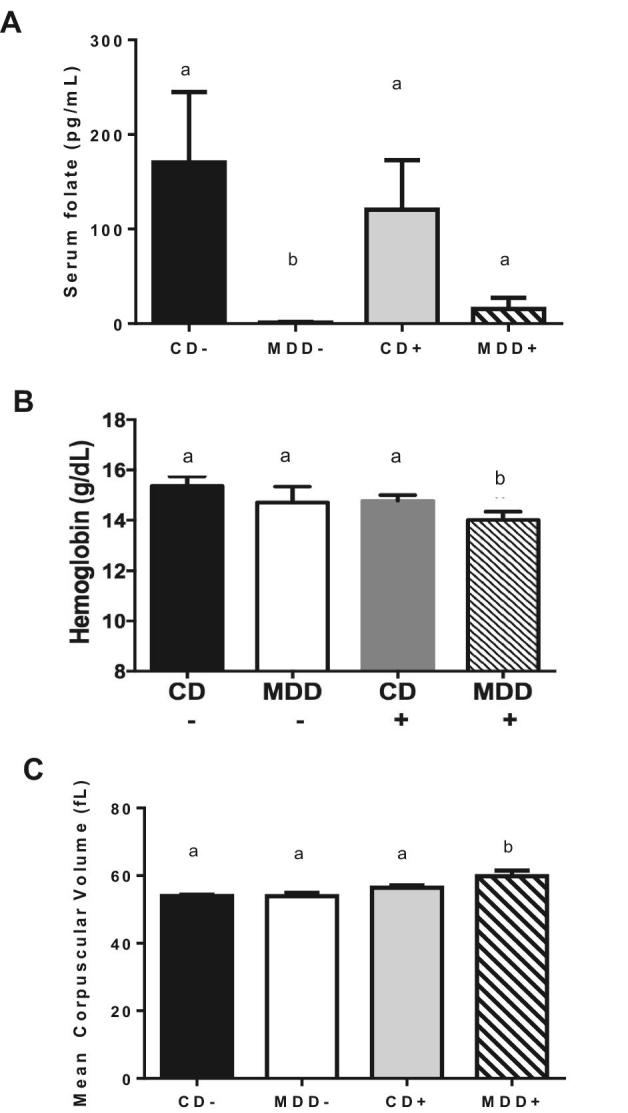
Combined prenatal and postnatal methyl donor deficiency leads to low serum folate and macrocytic anemia. (A) Prenatal and subsequent exposure to isocaloric diets lacking folate and choline induces folate deficiency, here represented by a decrease of >80% in the serum folate concentrations in both MDD groups compared with controls. Systemic manifestations of folate deficiency in the MDD+ group included (B) decreased hemoglobin concentrations and (C) increased mean corpuscular volume of RBCs. Values are means ± SEMs, n = 4–10. Means without a common letter differ, P < 0.05. CD+/−, control diet with/without succinylsulfathiazole; MDD+/−, methyl donor–deficient diet with/without succinylsulfathiazole.